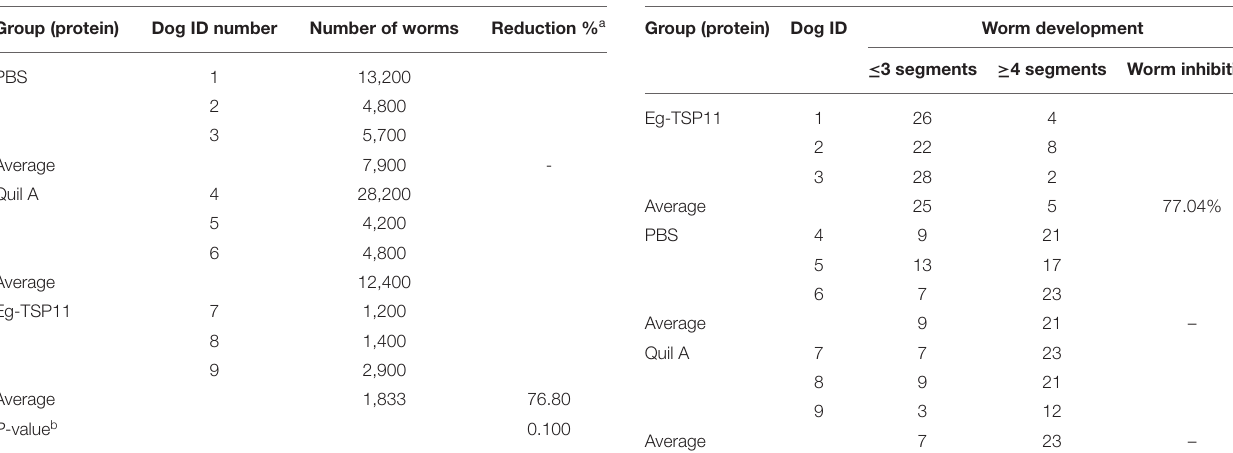
TABLE 2 | Worm segment development in the experimental